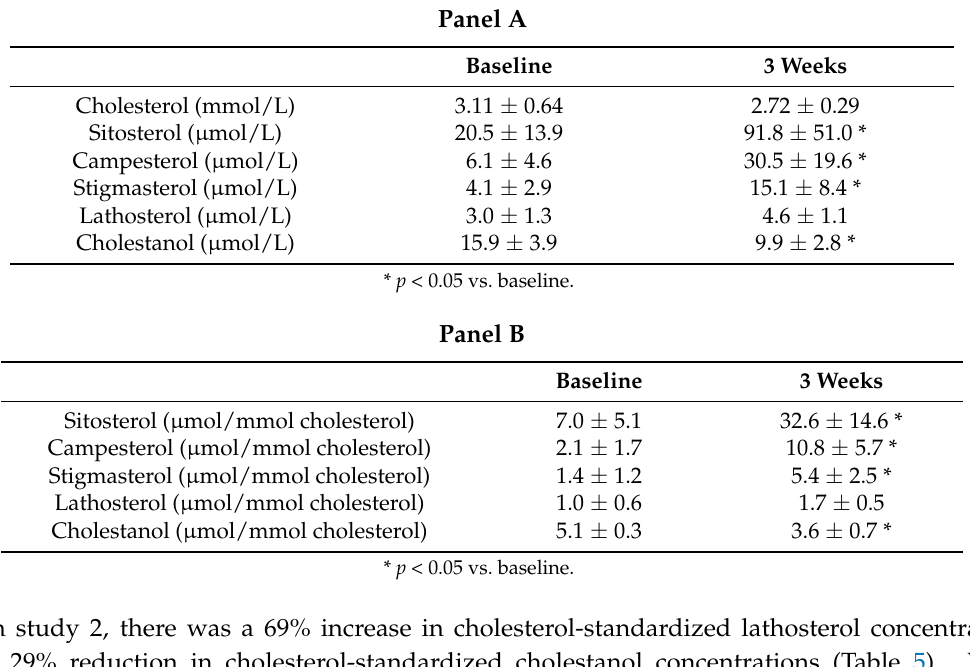
Table 5. Serum non-cholesterol sterol concentrations, absolute ( µ mol/L) in panel A, and cholesterol standardized ( µ mol/mmol cholesterol) in panel B, baseline and after 3 weeks of a soy-based lipid emulsion (Study